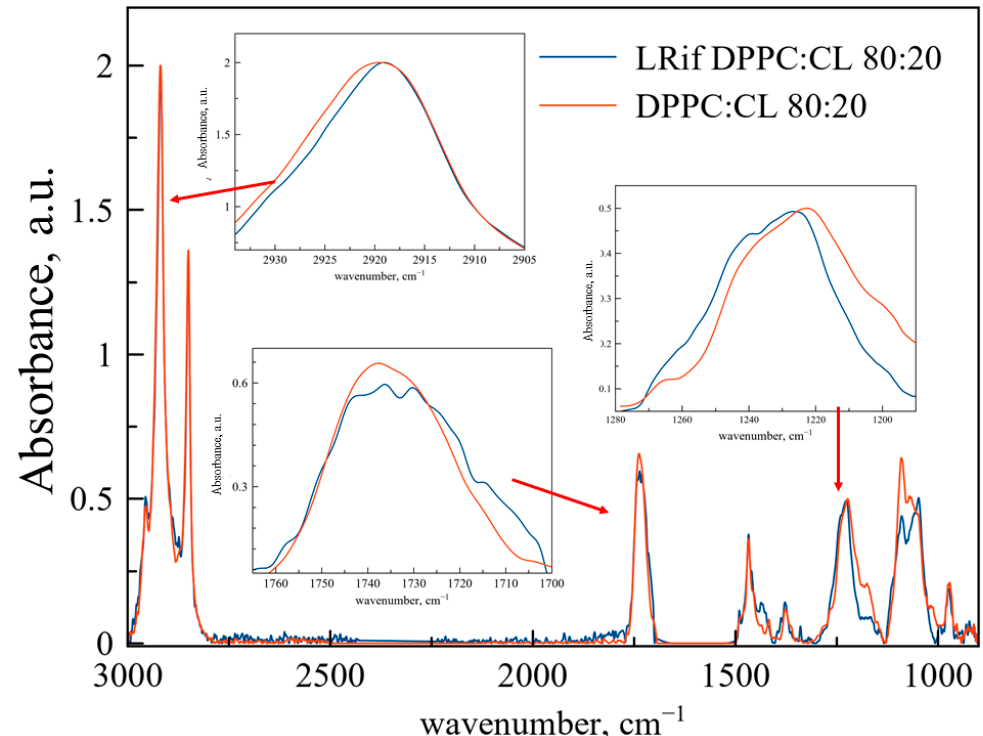
Figure 3. Normalized ATR-FTIR spectra of DPPC:CL 80:20 weight% liposomes and LRif. Total lipid concentration 5 mg/mL, 0.02 M sodium phosphate buffer solution pH 7.4, 22 ° C. Rif spectra were subtracted as a background. Spectra of empty liposomes are red, spectra of LRif are blue. In the insets, areas of ν as (CH 2 ) , ν (CO) , ν as (PO 2 − ) are presented. The absorption band of the carbonyl group splits into several pronounced